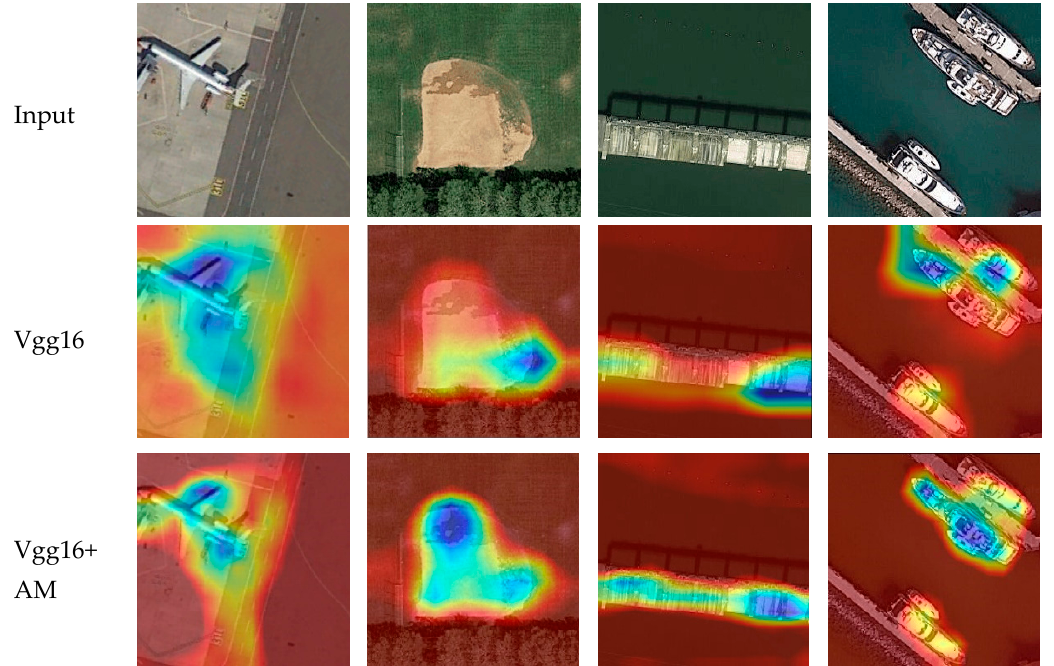
Figure 9. Grad-CAM (Gradient-weighted Class Activation Mapping) visualization results.